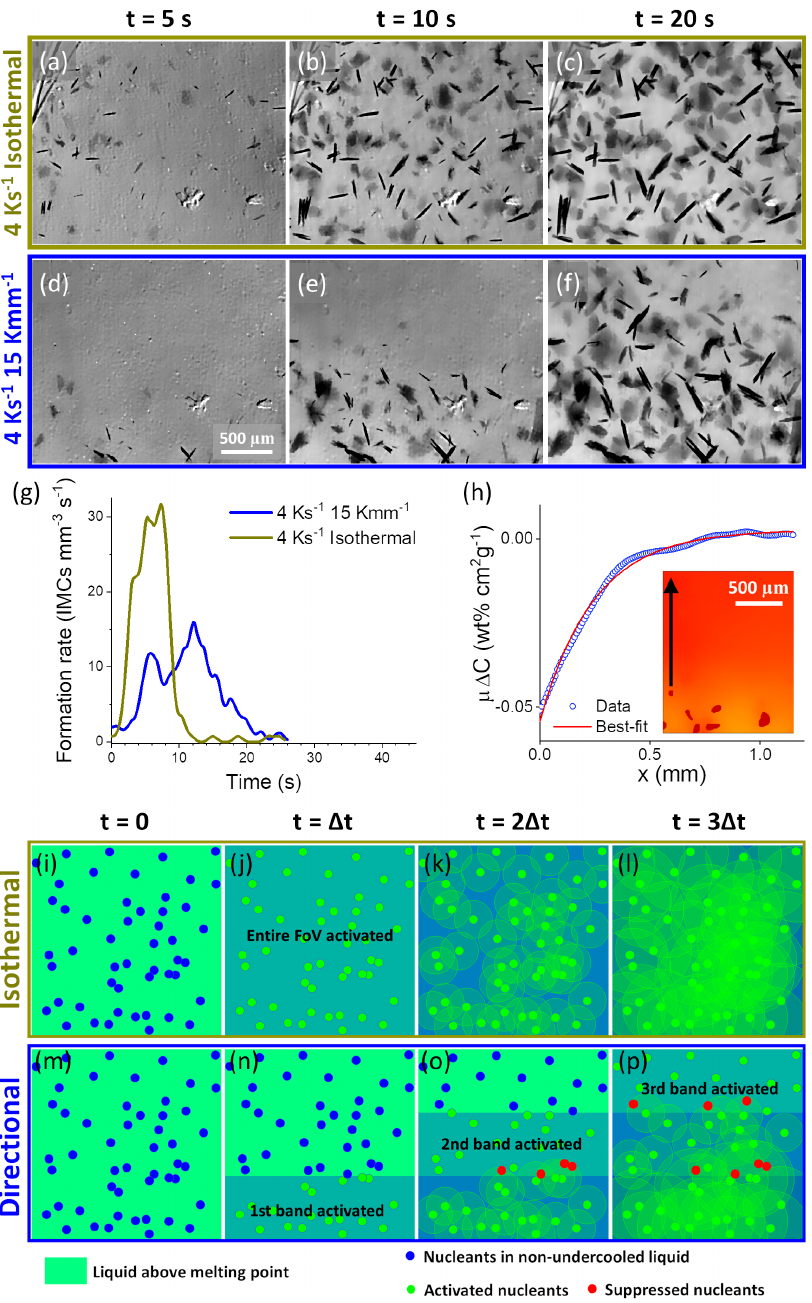
Figure 7. ( a – c ) A radiograph sequence showing the formation of primary IMC crystals at 4Ks − 1 under isothermal cooling. ( d – f ) A radiograph sequence at 4Ks − 1 and 15Kmm − 1 . ( g ) Corresponding time resolved IMC formation rate for the two sequences. ( h ) The micro-segregation of Pt ahead of a typical IMC, measured along the black arrow in the inset radiograph of the Pt diffusion field, with a best-fit to equation y = a + b e − cx ( R 2 = 0.994). µ is the X-ray mass attenuation coefficient of Pt (constant), and ∆ C is the difference between the local Pt concentration ahead of a growing IMC and the bulk Pt concentration. Schematics illustrating the nucleants activated at each time instant under ( i – l ) ideally isothermal, and ( m – p ) directional solidification [18] (Reprinted with permission from [18]. Copyright 2021